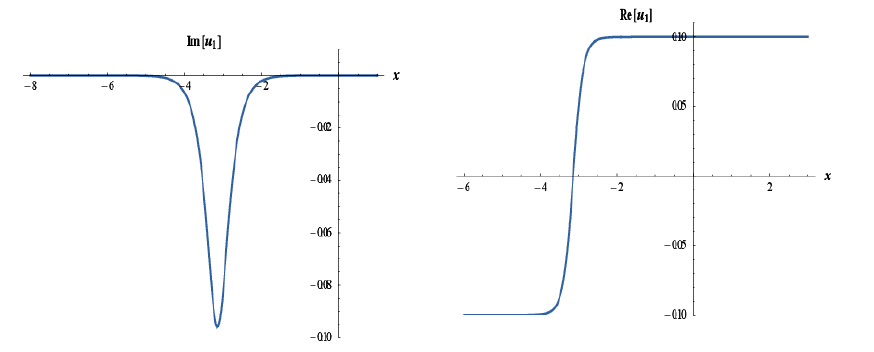
Figure 12. Two-dimensional graphs of imaginary and real part of